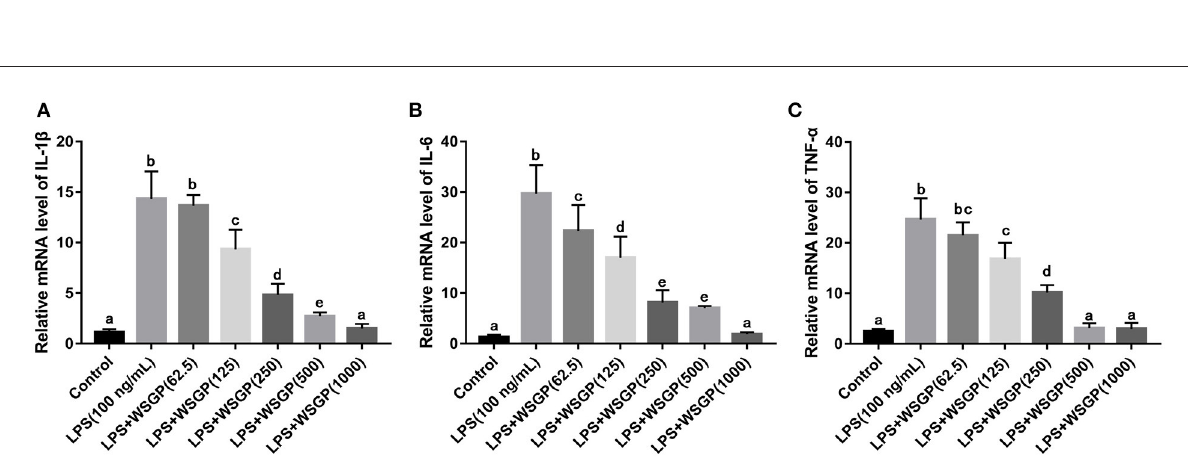
FIGURE6 Effects of WSGP on mRNA levels of IL-1 β (A) , IL-6 (B) , and TNF- α (C) in LPS-induced RAW264.7 macrophages. The data were expressed as means ± SD from three independent experiments. Values with different letters indicate significant difference ( p < 0.05).